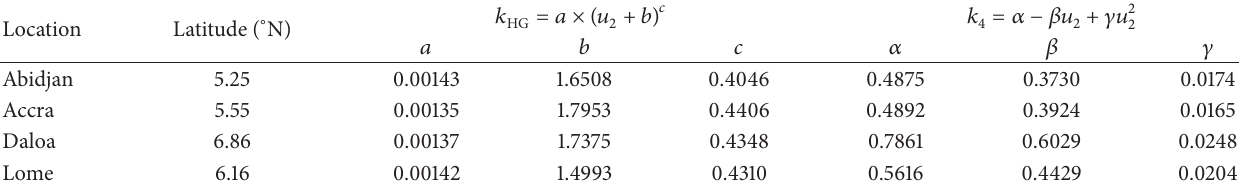
and 𝑘 4 parameters of LHGu equation for 𝑢 2 range 0.5–6.0 m/s. HG